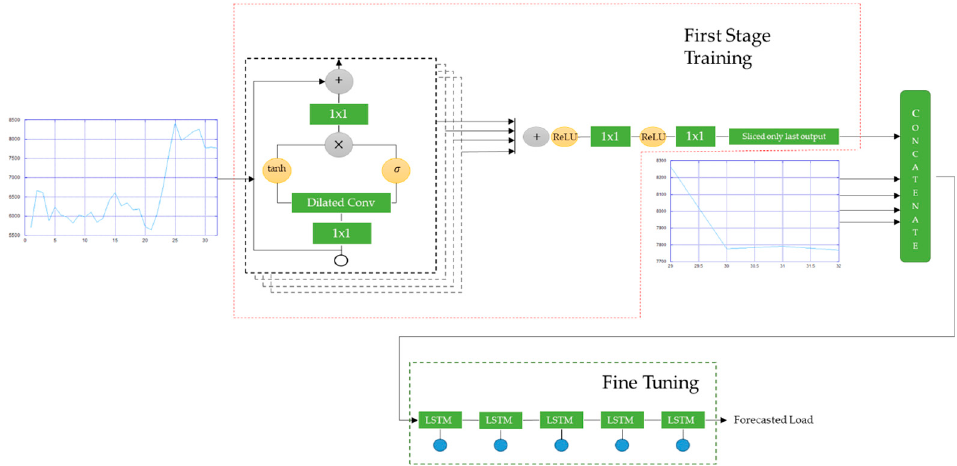
Figure 8. Proposed model architecture.